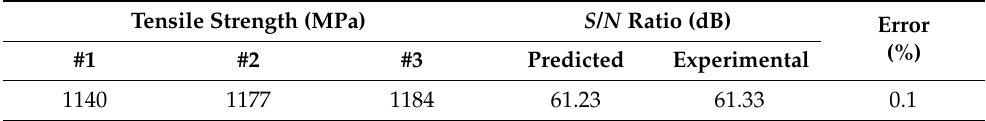
Table 4. Comparison between experimental and predicted optimal tensile strength.